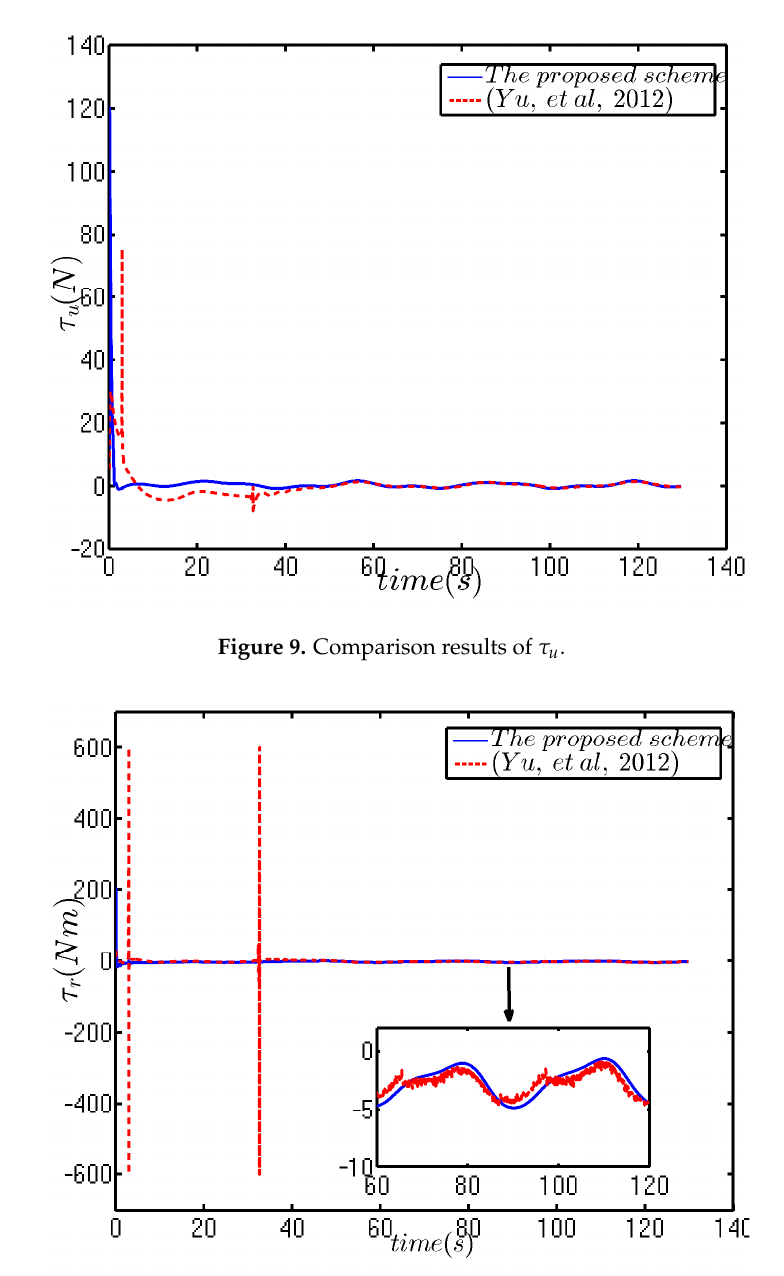
Figure 10. Comparison results of τ r